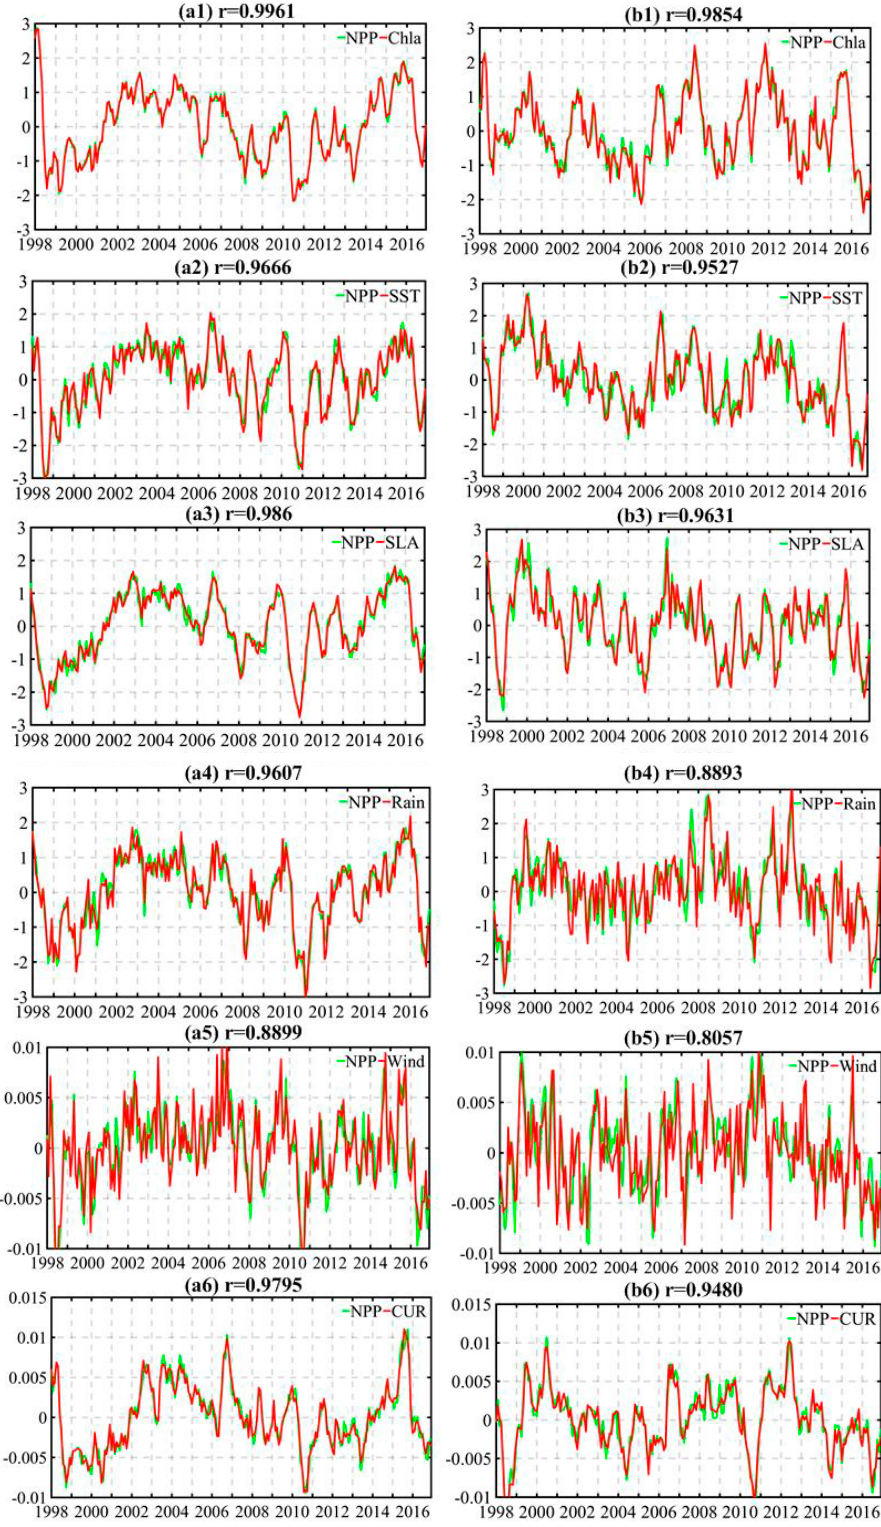
Figure 8. The time series and correlation coefficient of canonical coupled BPCCA modes associated with ENSO (left panel) and IOD (right panel), respectively. ( a1 ) the canonical time series of NPP (green line) and Chla (red line) associated with ENSO, ( b1 ) the canonical time series of NPP (green line) and Chla (red line) associated with IOD. ( a2 – a6 , b2 – b6 ) are the same as ( a1 , b1 ) but for the modes of NPP with SST, SLA, Rain, Wind, and CUR.